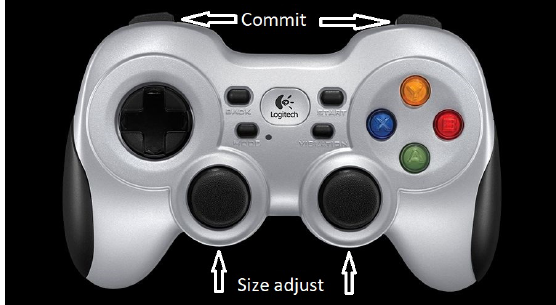
Figure 5. Logitech F710 wireless game controller.